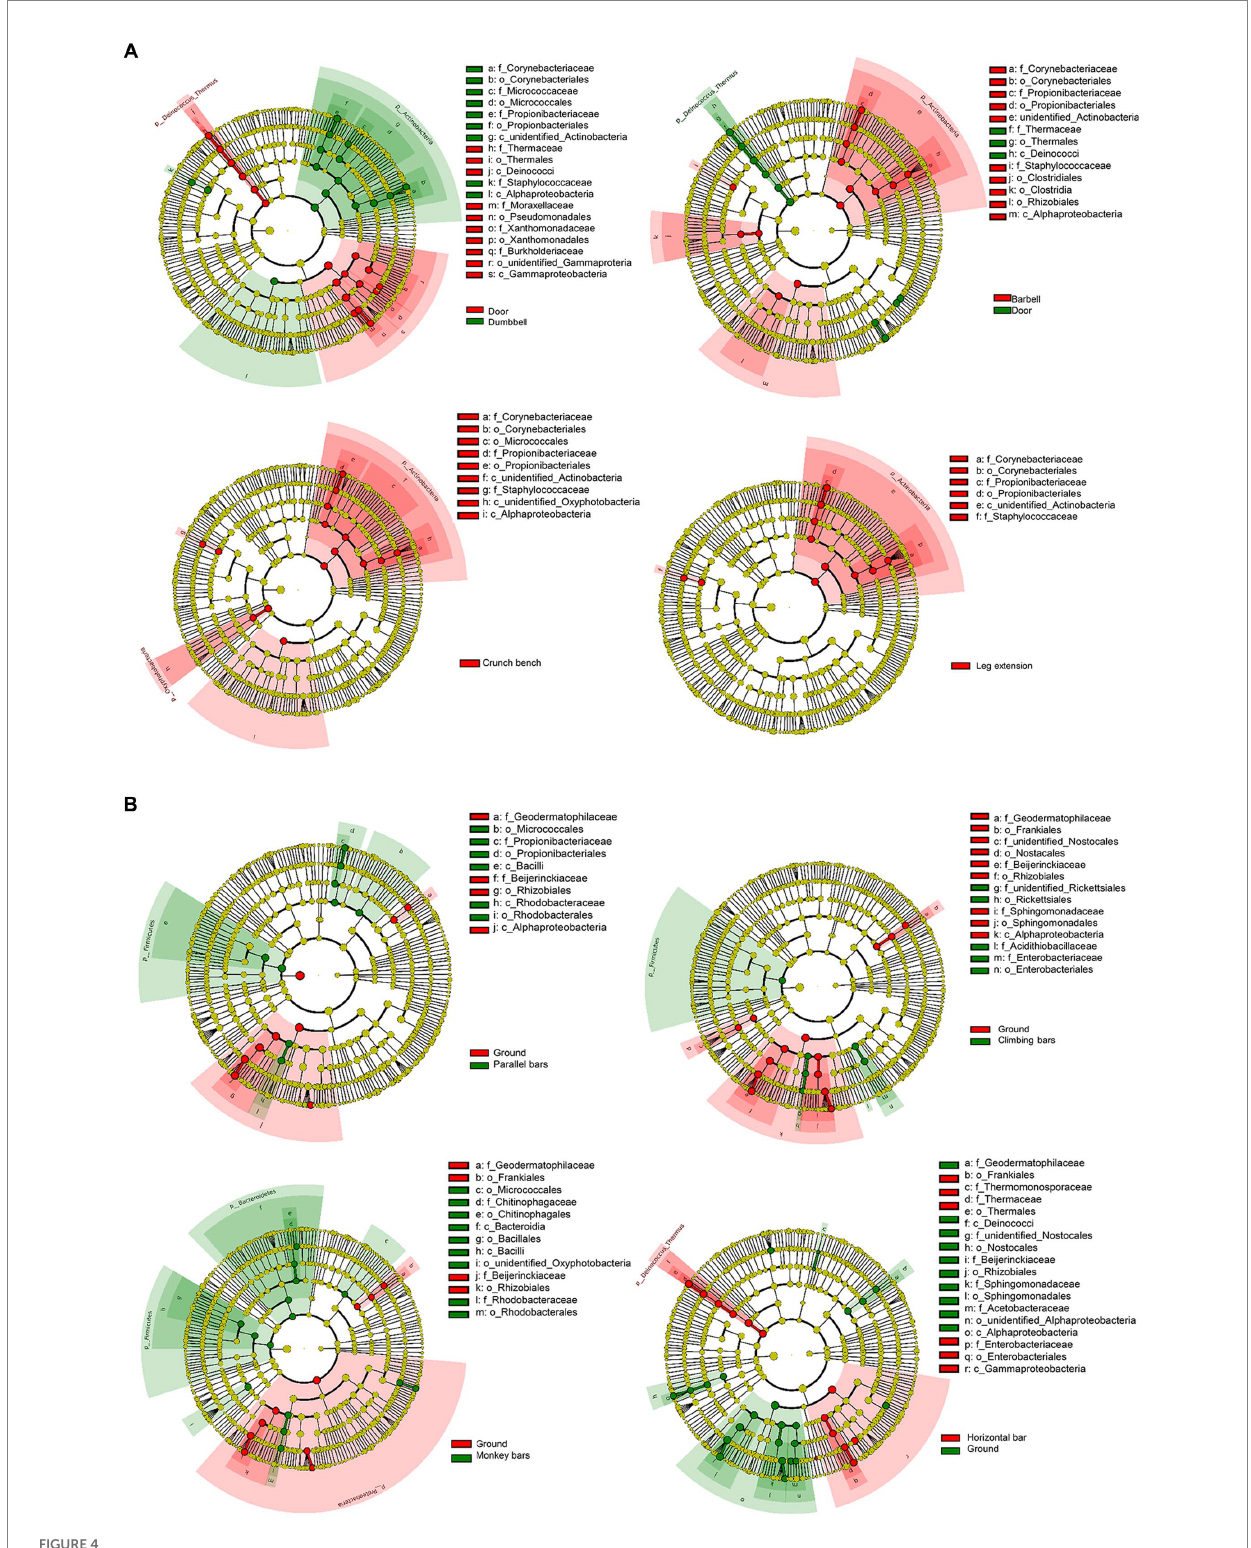
FIGURE 4 Bacterial enrichment on the surfaces of different gymnastic equipment. (A) Comparison of door and indoor equipment. (B) Comparison of ground and outdoor